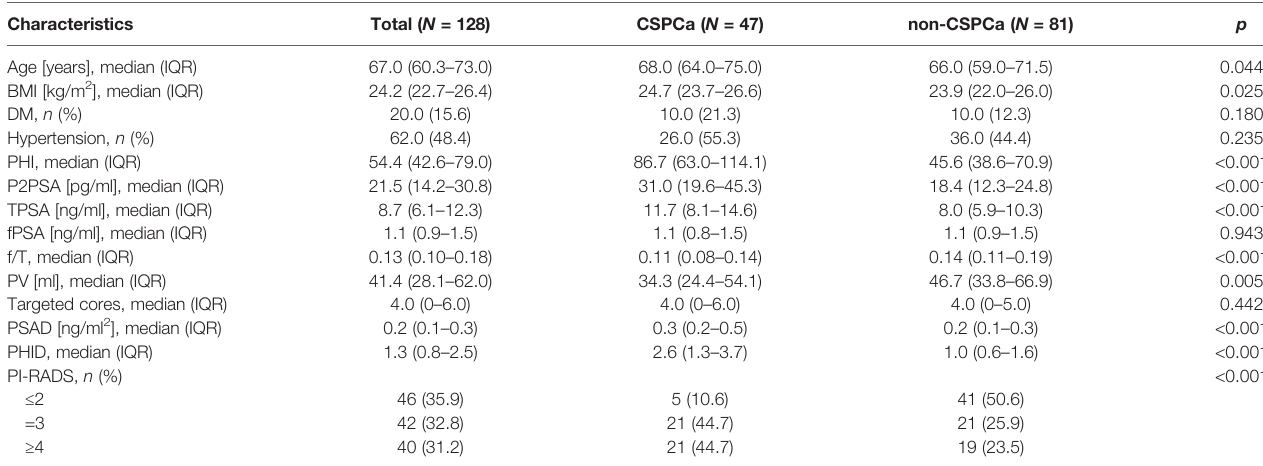
TABLE 1 | Patients ’